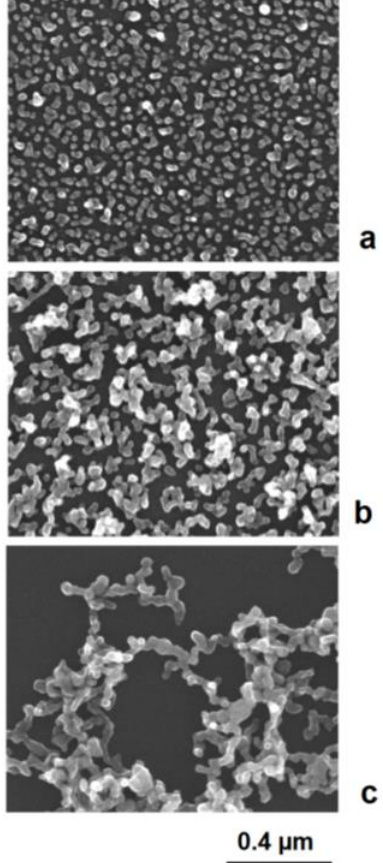
Figure 8. In situ formation of aggregate particles during the chemical deposition of silver nanoparticles on gold seeds: ( a ) small aggregate particles; ( b ) enhanced aggregate size; ( c ) network formation.